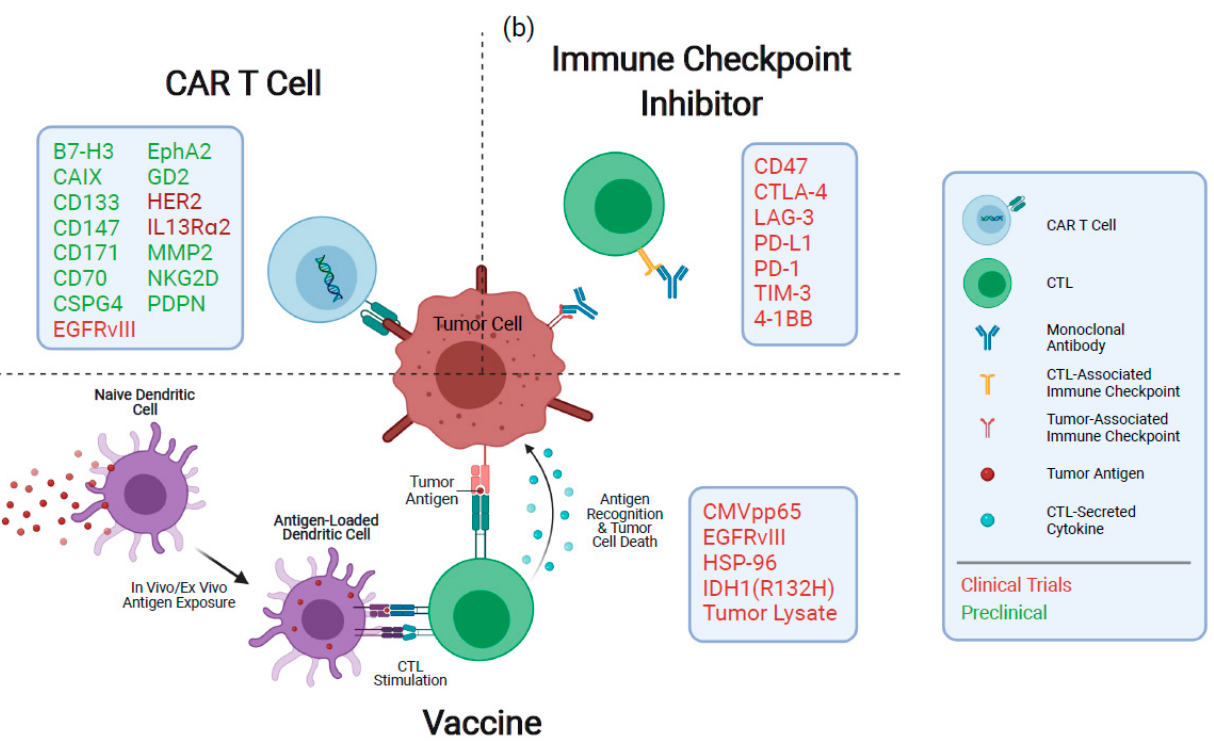
Figure 1. Overview of current immunotherapeutic modalities being investigated to treat GBM. ( a ) CAR T cells recognize antigens through a genetically engineered extracellular receptor which triggers intracellular T cell activation and degranulation upon antigen binding. ( b ) Inhibitors of immune checkpoint proteins prevent their attenuation of immune responses upon activation and exhaustion. ( c ) Vaccines expose antigen-presenting cells to tumoral antigens, stimulating a target-specific immune response. Boxes indicate therapeutic targets or mediators being pursued for each modality. CAR: chimeric antigen receptor; CTL: cytotoxic T lymphocyte.